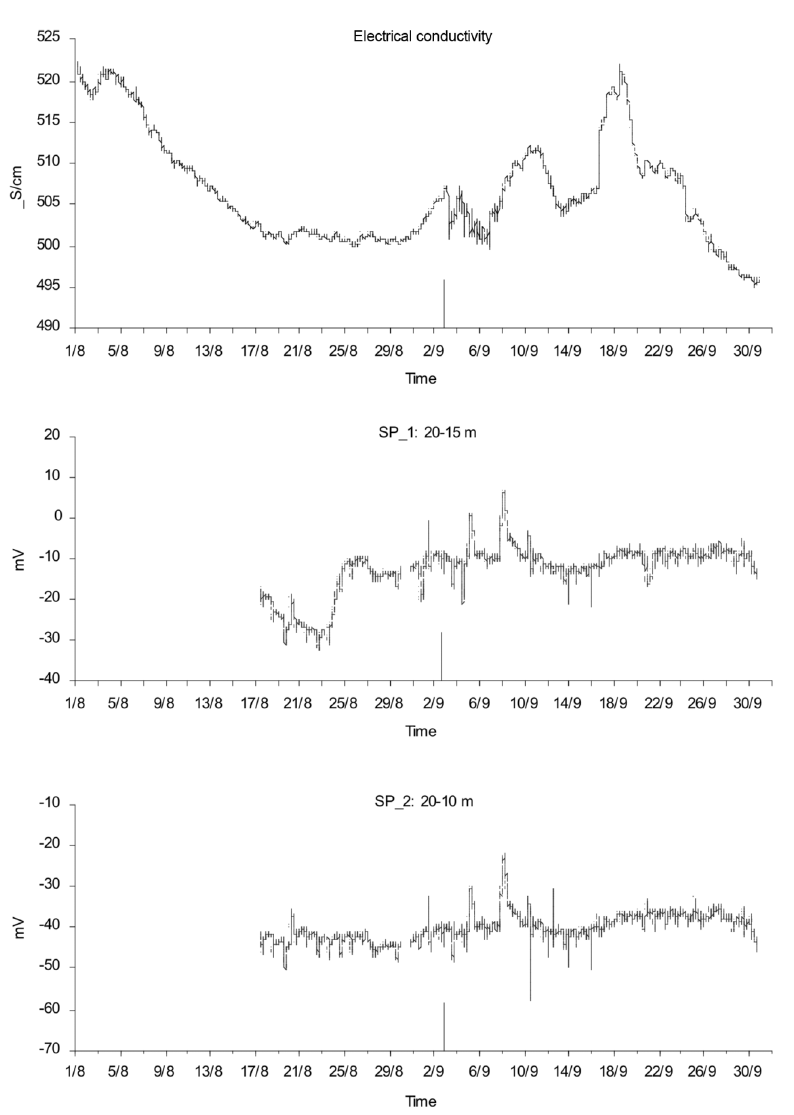
Fig. 7. Water conductivity and self potential signals recorded at the Tito station: August-September 2004. Sharp variation is present during and after seismic sequence on both